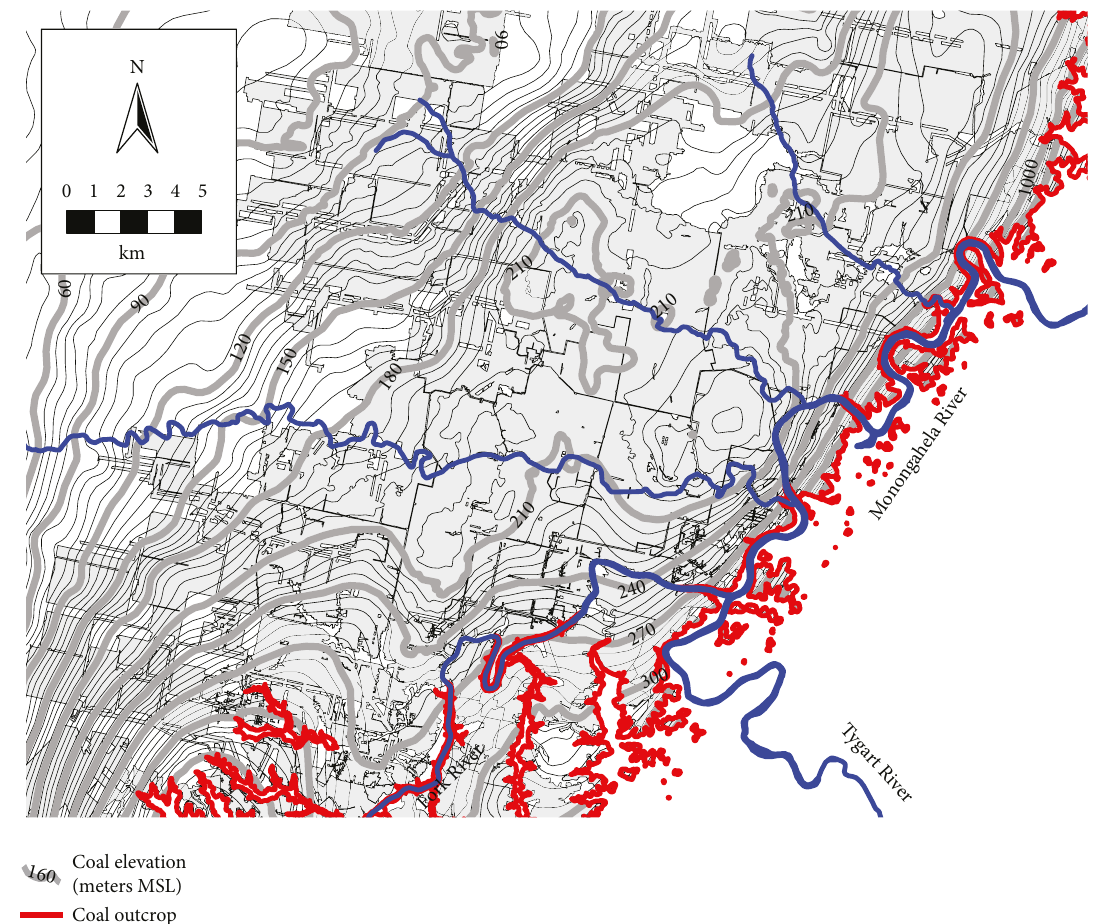
Figure 3: Structure contours of the base of the Pittsburgh coal, in meters MSL. Contour interval 6m. Bold red line indicates coal